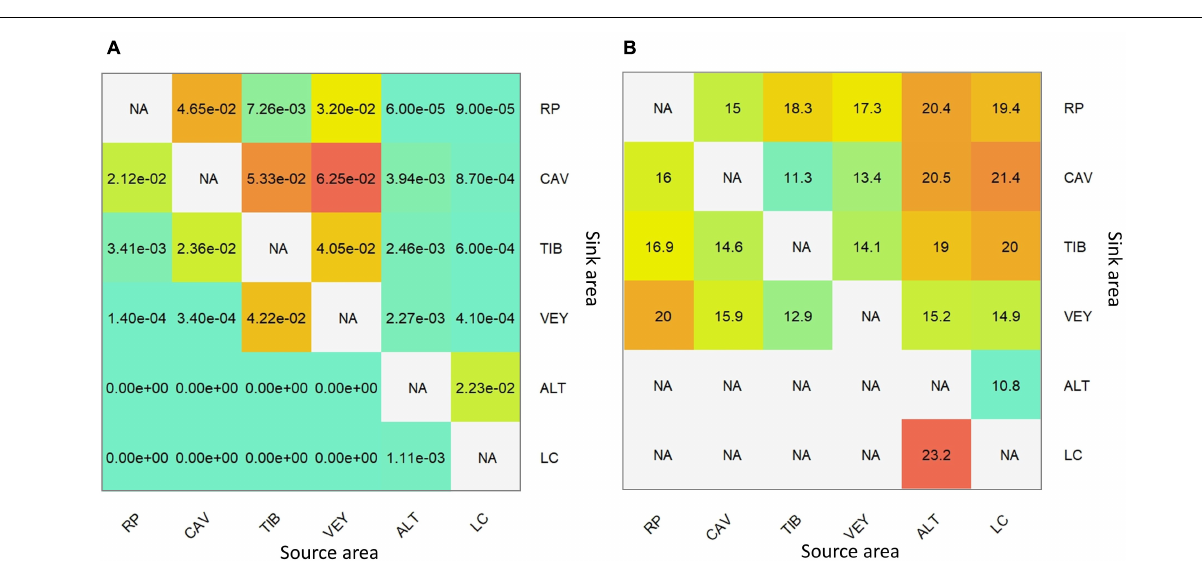
FIGURE 6 | Pairwise oceanographic connectivity from the source area to sink area. (A) The average probability of dispersal between populations with (B) the associated mean time of particle transport (in day). NA value of the diagonal matrices denotes that self-recruitment was not considered; another NA indicates the absence of dispersal between populations to compute transport